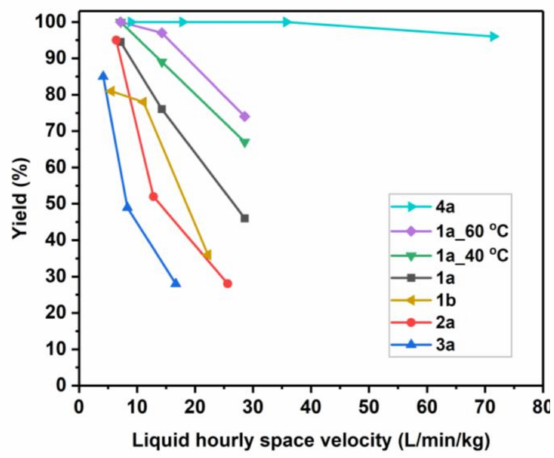
Figure 2. The plot of yield vs. liquid hourly space velocity (LHSV) for reactors 1–4. UiO66 crystal sizes of 14, 200, and 540 nm, 1a , 2a , and 3a , respectively, were tested, as shown